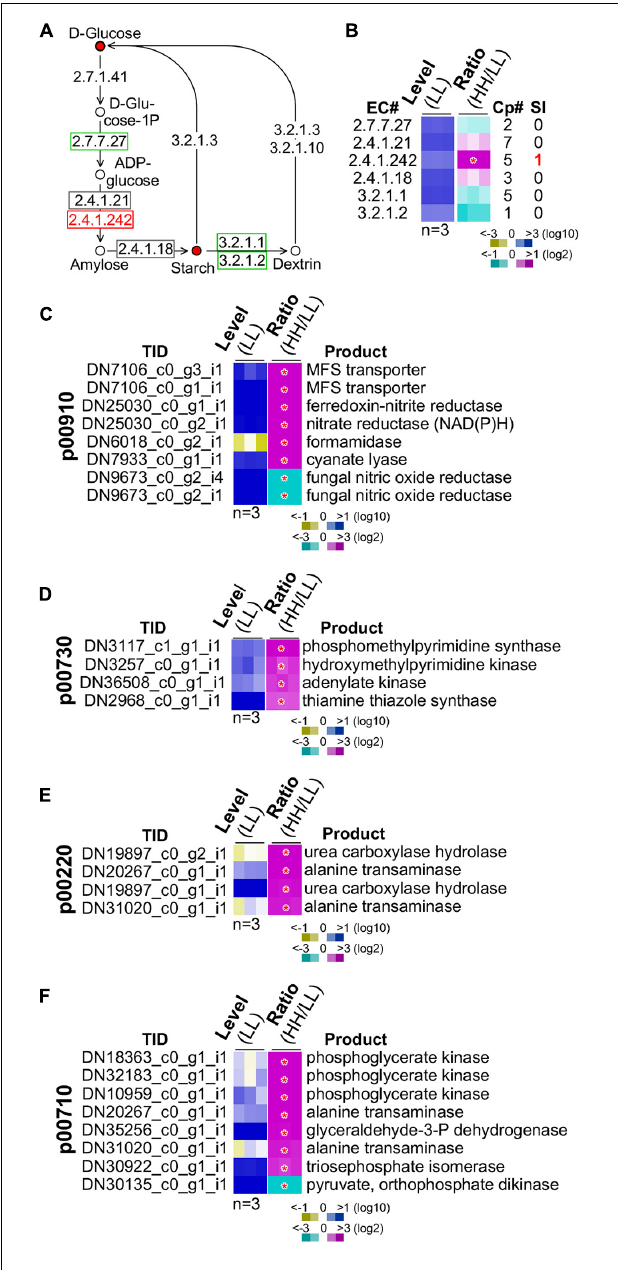
FIGURE 6 | Regulation of starch biosynthesis and GSR genes enriched functions. (A) Schematic drawing of the starch biosynthesis pathway. The display is identical to Figure 5A . (B) Heatmap of transcription level change of enzymes involved in starch biosynthesis. The display is identical to Figure 5B . Heatmaps of profiles of GSR genes involved in (C) nitrogen metabolism (p00910), (D) thiamine metabolism (p00730), (E) arginine metabolism (p00220), and (F) carbon fixation (p00710). Transcript ID and its putative product are shown. The display is identical to (B)